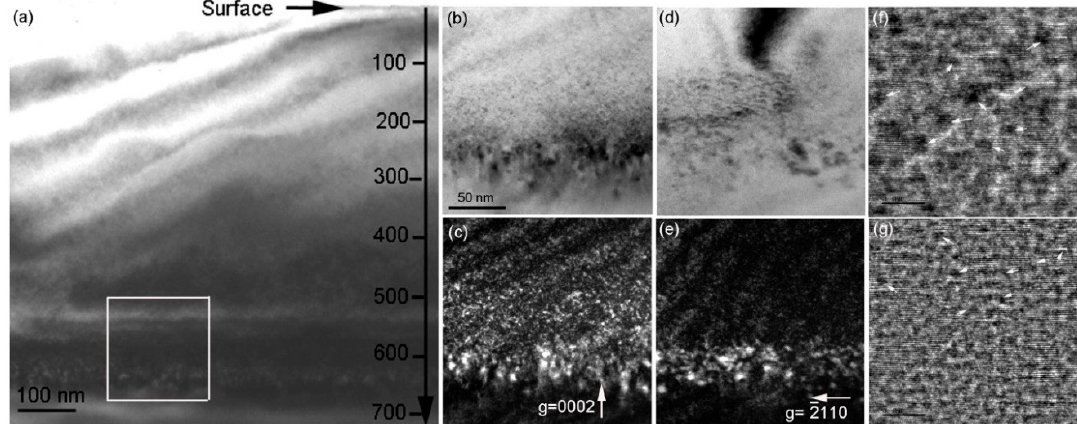
Figure 5. Bright-field XTEM image showing the over-viewed damage distribution in the 194 keV H 2+ -implanted 6H-SiC at 450 °C. The enlarged selected zone shown in ( a ) is presented in ( b ) to ( e ), where ( b ) BF and ( c ) WBDF images were observed under g = 0002 and ( d , e ) were observed under g = 2110. ( f ) The high-resolution transmission electron microscope image shows lattice defects exhibiting a dark contrast, as indicated by white arrows and ( g ) inverse Fourier-filtered image of ( f ) in order to improve the visibility of lattice defects. ( c – e ) have the same scale as ( b ).